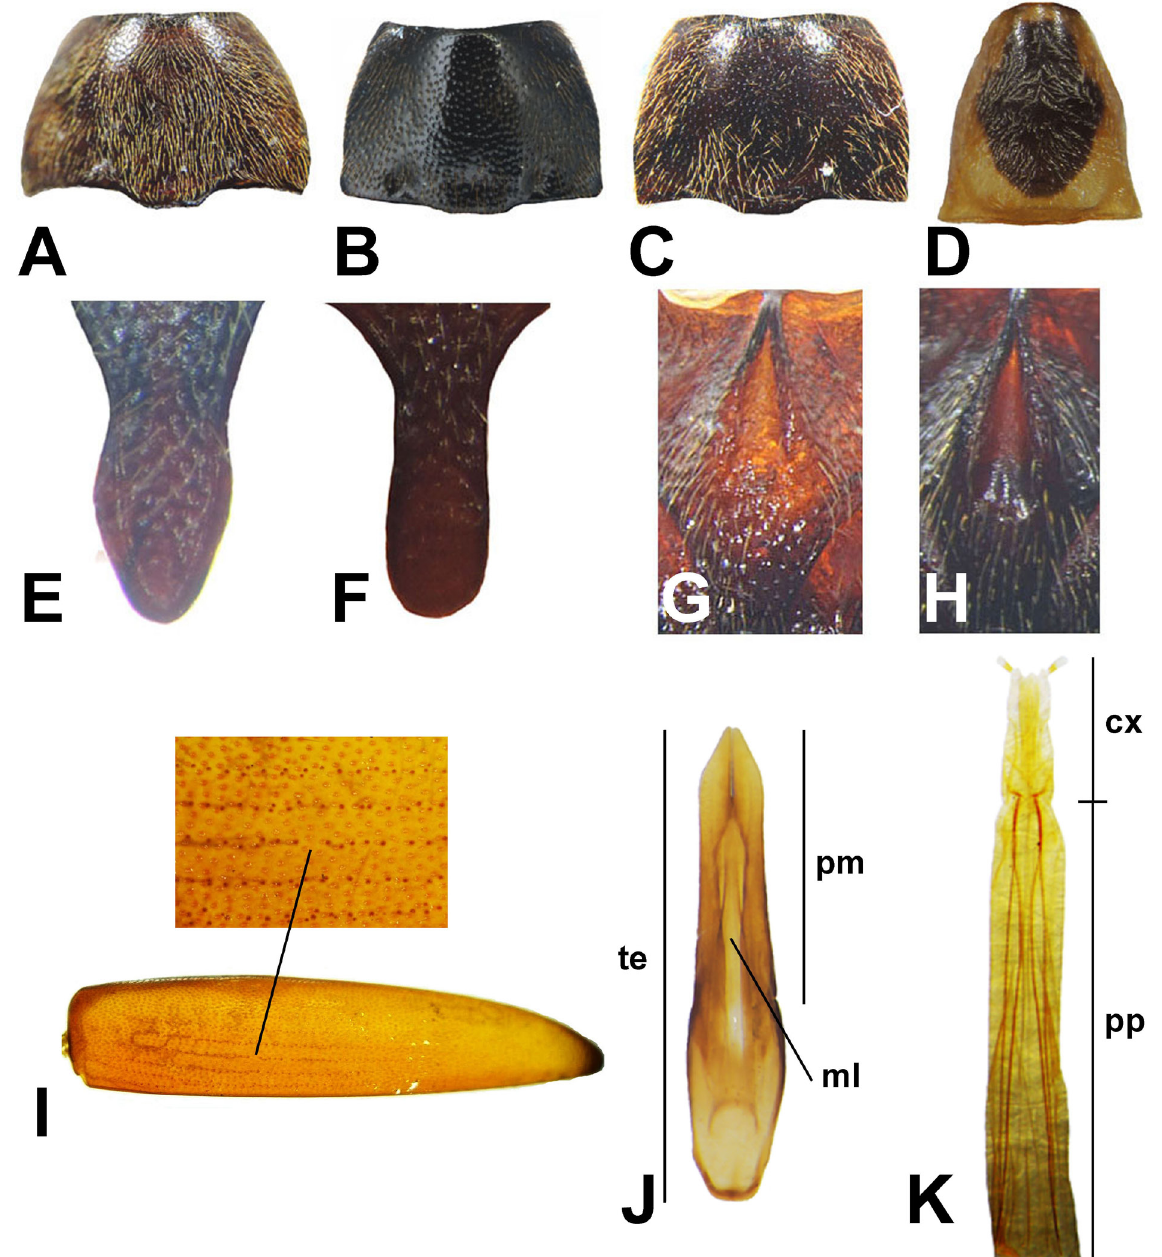
Fig. 2. Morphological characters used for the analysis and key. A–D . Pronotum. E–F . Prosternal process. G–H . Mesoventral cavity. I . Elytral striae. J . Aedeagus. K .